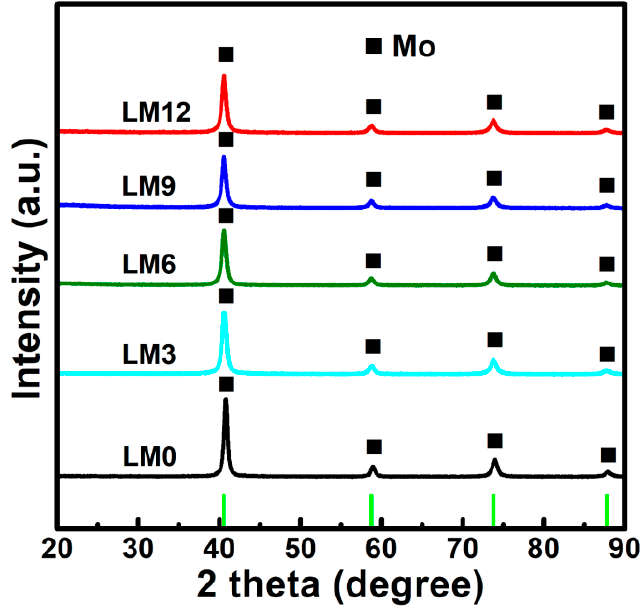
Figure 7. XRD patterns of products reduced by the Ar calcination-H 2 reduction process. Table 4. The content of C in the products reduced through different reduction processes.